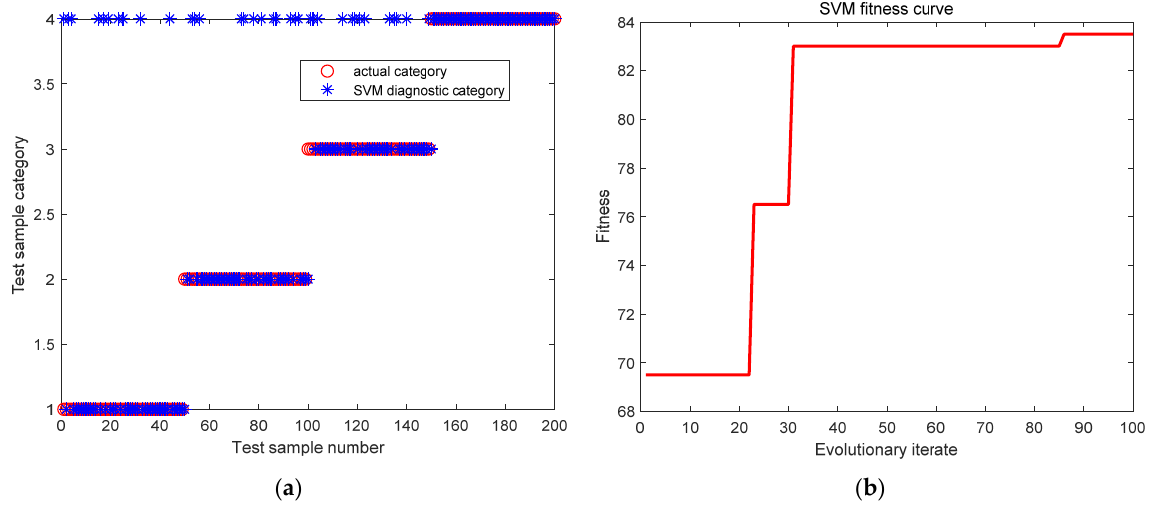
Figure 10. The test results based on traditional SVM model. ( a ) The classification results ( b ) The fitness change curve.